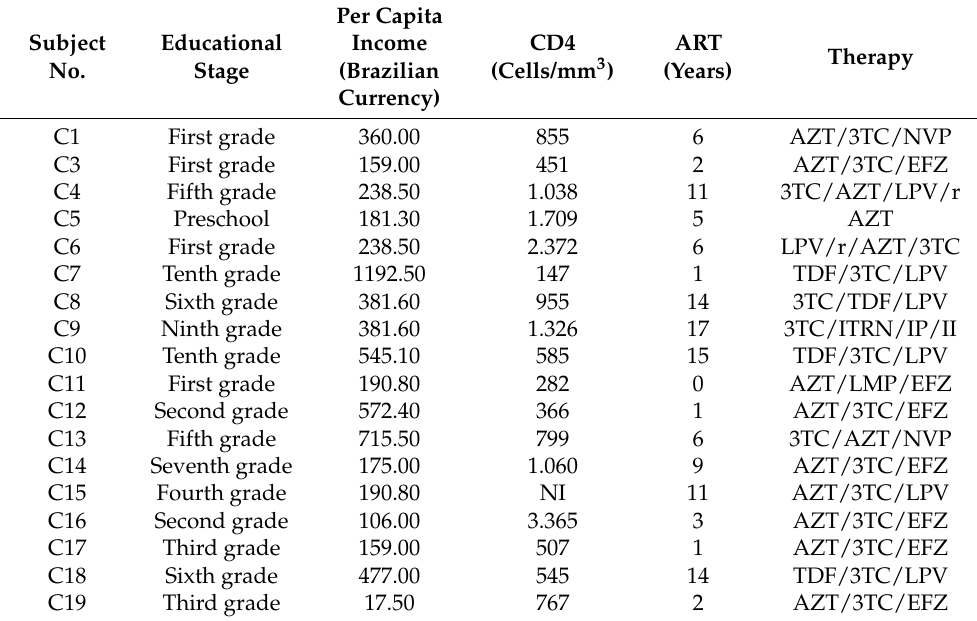
Table 1. HIV + group characteristics ( n =